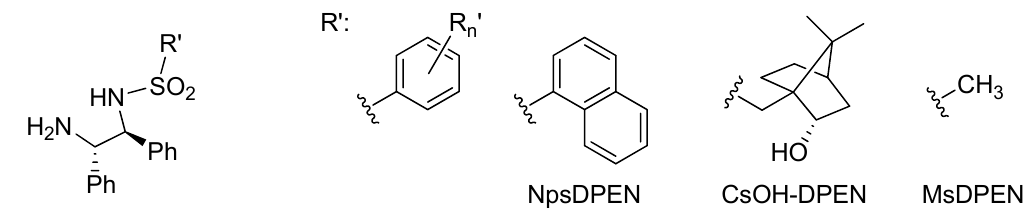
Figure 2. Examples of reported N-aryl and N-alkylsulfonyl diamine ligands.